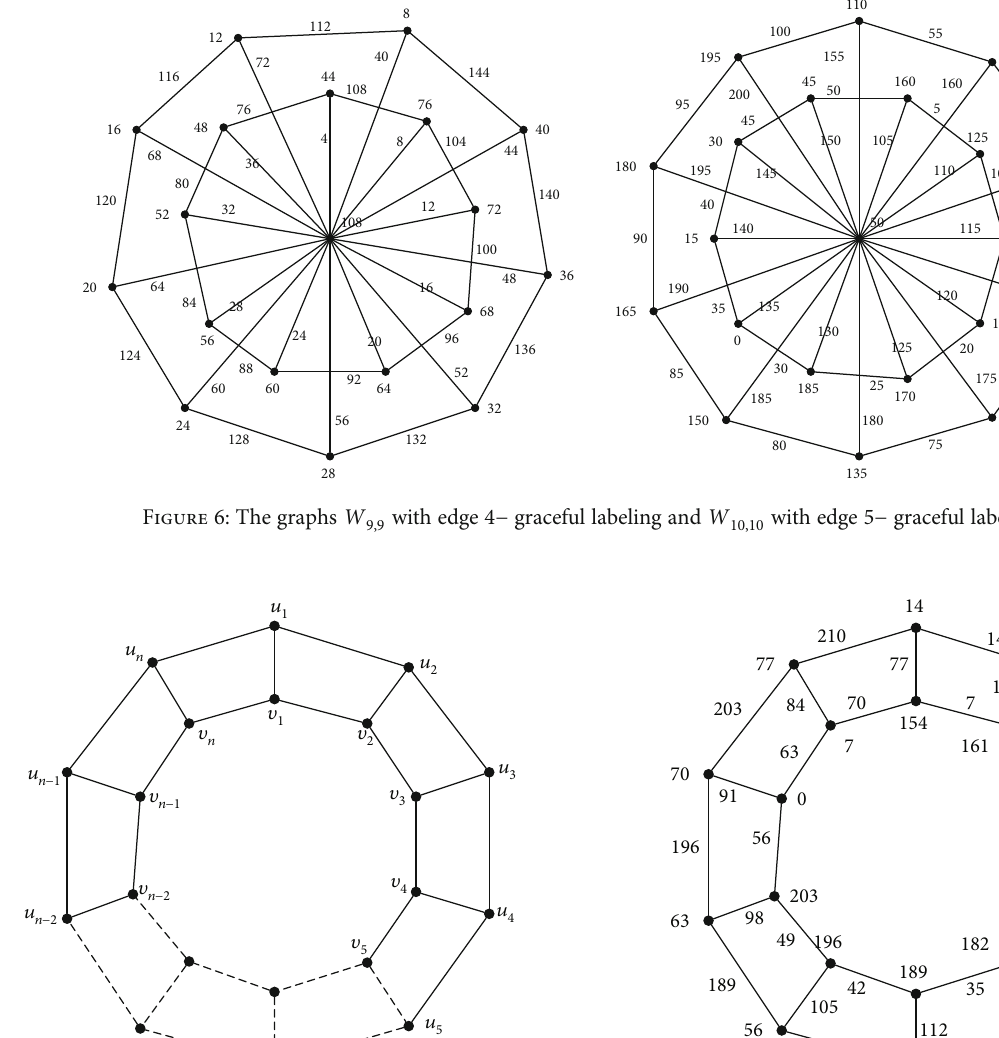
Figure 7: The prism graph Π